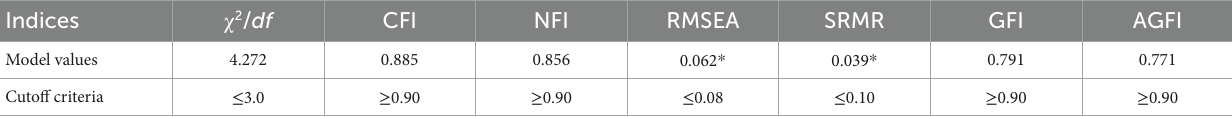
TABLE 3 Model fit indices of the initial